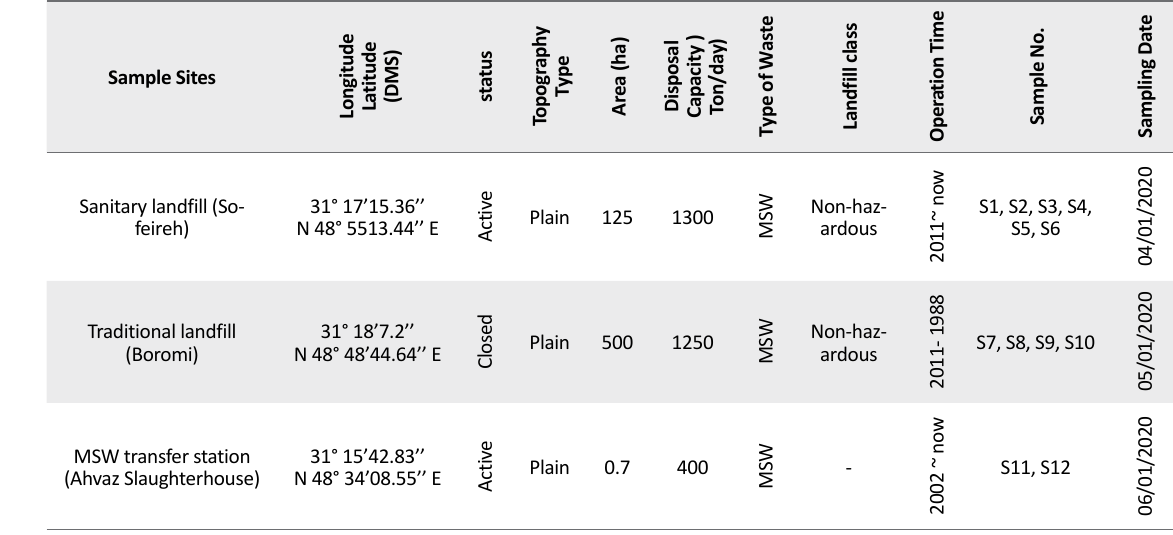
Table 1. Locations and description of the sampling sites